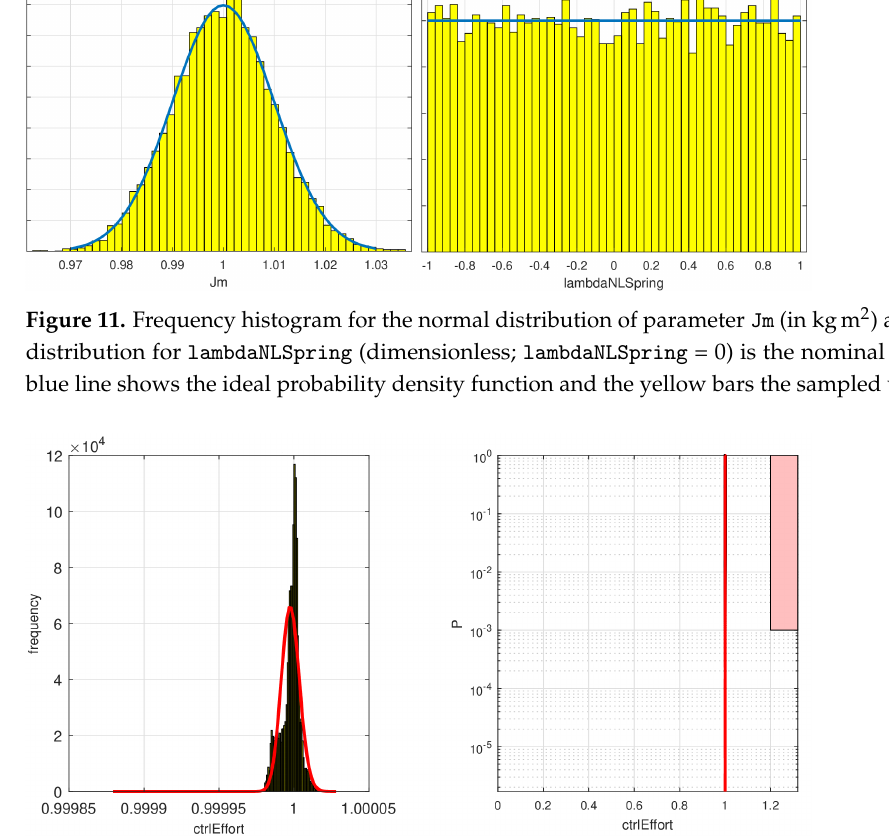
Figure 12. The left figure shows the resulting cumulative distribution function (CDF, here a gamma distribution was used) for the model output ctrlEffort calculated by MOPS. On the right side, the risk area for the criteria is shown in light red with a black border. The shaded area indicates probability values greater or equal to 0.1%, i.e., the probability calculated from the estimated CDF allows us to conclude the risk is